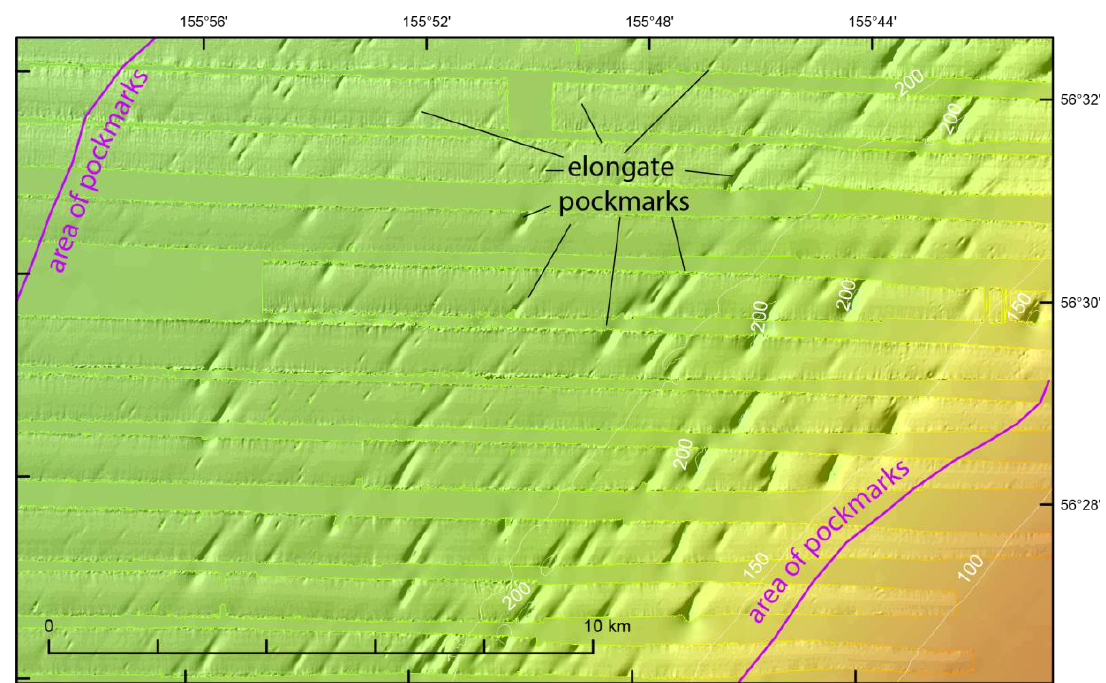
Figure 8. Pockmarked area on the east side of Shelikof Straight. Location of figure is shown on Figure 5, and the symbology is the same. These pockmarks are variable in size and are notably aligned with the glacier flow direction.